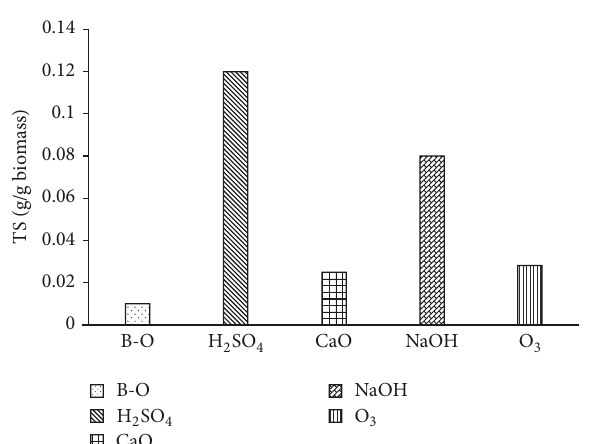
Figure 4: Effect of different pretreatments on the generation of total sugars.